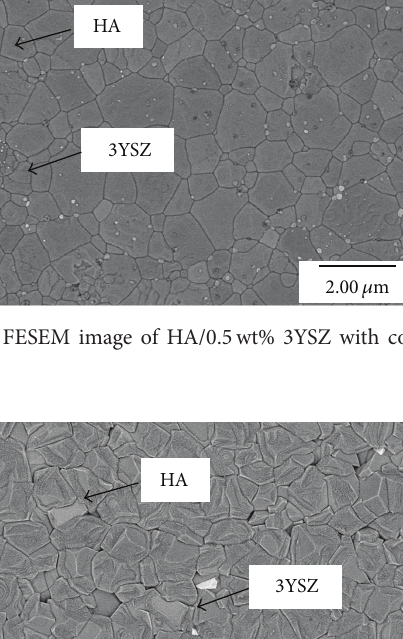
Figure 9: Average grain size of HA containing different amounts of 3YSZ.